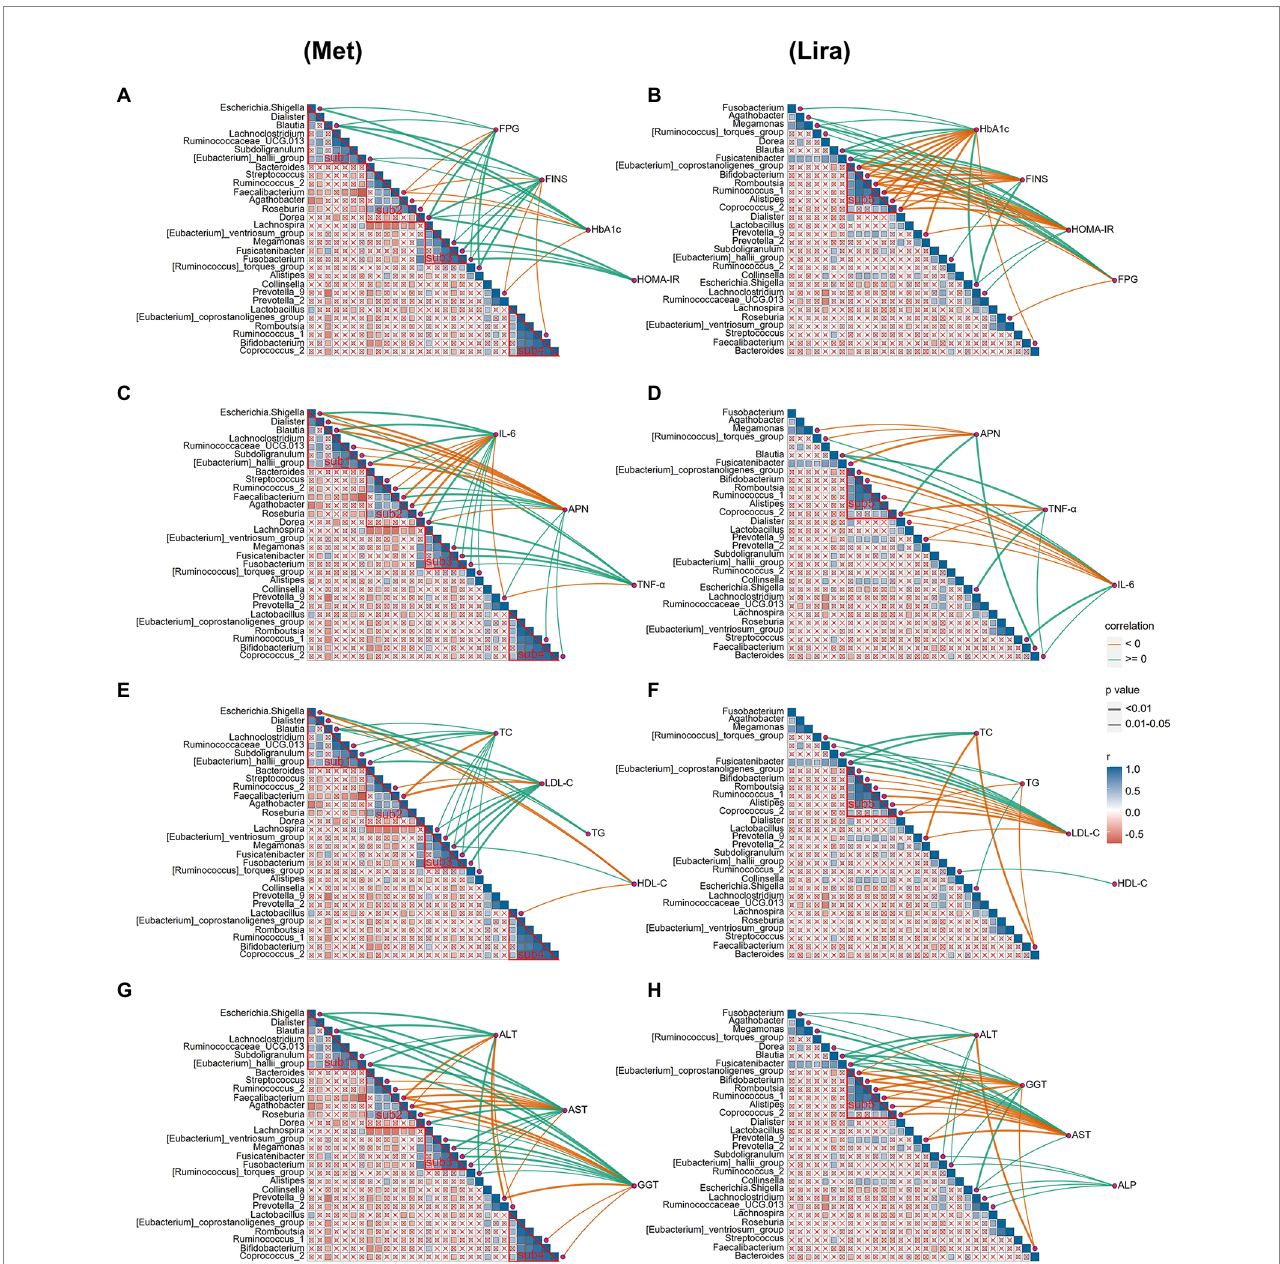
FIGURE 6 (A) Correlation analysis of islet β cell indices and intestinal bacterial community after metformin treatment. (B) Correlation analysis of islet β cell indices and intestinal bacterial community after liraglutide treatment. (C) Correlation analysis of inflammation-related factors and intestinal bacterial community after metformin treatment. (D) Correlation analysis of inflammation-related factors and intestinal bacterial community after liraglutide treatment. (E) Correlation analysis of lipid metabolism indices and intestinal bacterial community after metformin treatment. (F) Correlation analysis of lipid metabolism indices and intestinal bacterial community after liraglutide treatment. (G) Correlation analysis of liver function indices and intestinal bacterial community after metformin treatment. (H) Correlation analysis of liver function indices and intestinal bacterial community after liraglutide